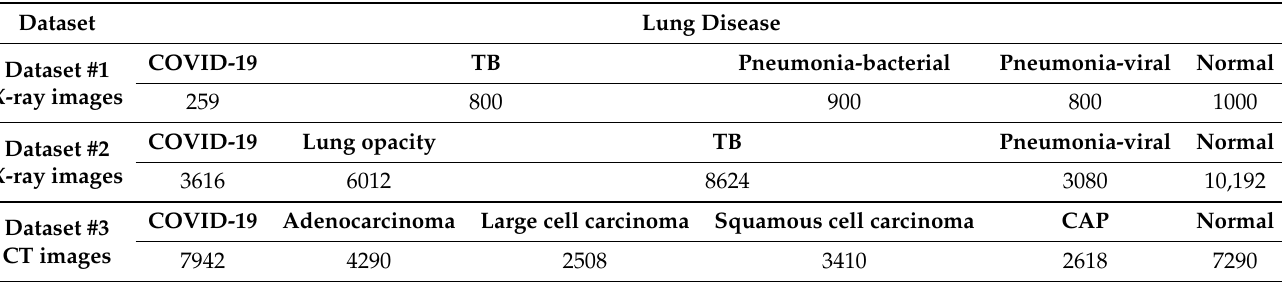
Table 1. Datasets